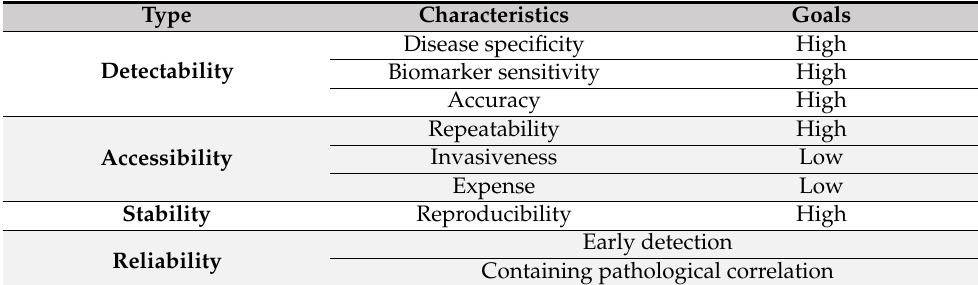
Table 3. Characteristics of ideal body fluid biomarker.